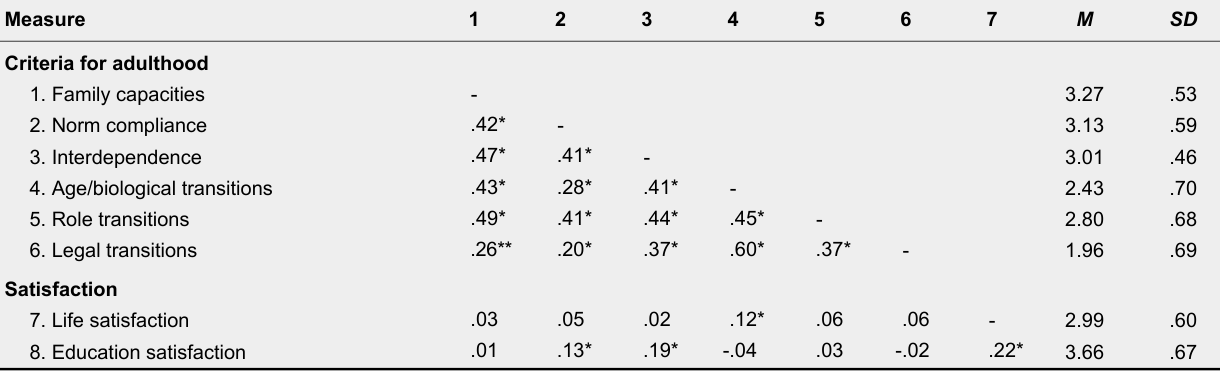
Bivariate Correlations Among Psychological Study Variables